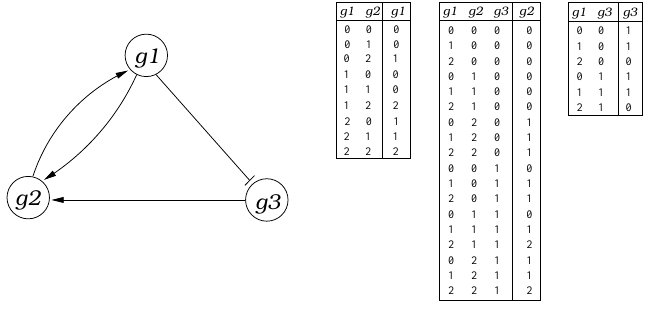
Figure 2: Multi-valued network with three entities g 1 , g 2 and g 3